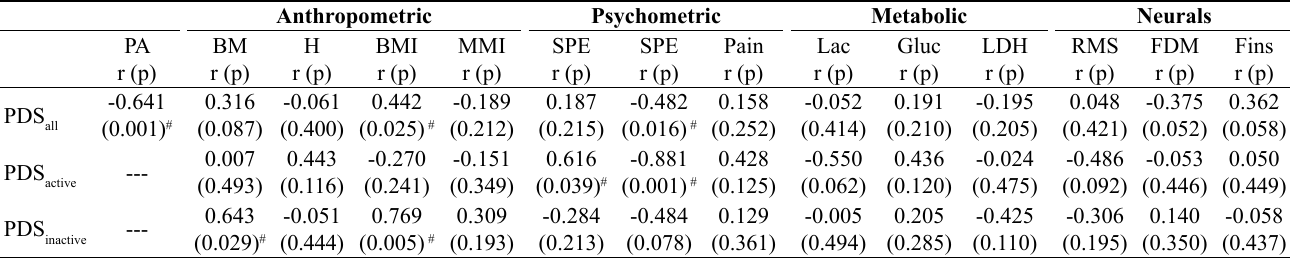
PDS=Percentage decrement score; PA=Physical activity; BM=Body mass; H=Height; BMI=Body mass index; MMI=muscle mass index; RPE =Subjective perception of effort; SPR=subjective perception of recovery; Pain=subjective perception of pain; Lac=lactate concentration; Gluc=glucose; LDH=lactate dehydrogenase; RMS=signal´s mean square root; FDM=median frequency; Fins=spectral index logarithm. # significant